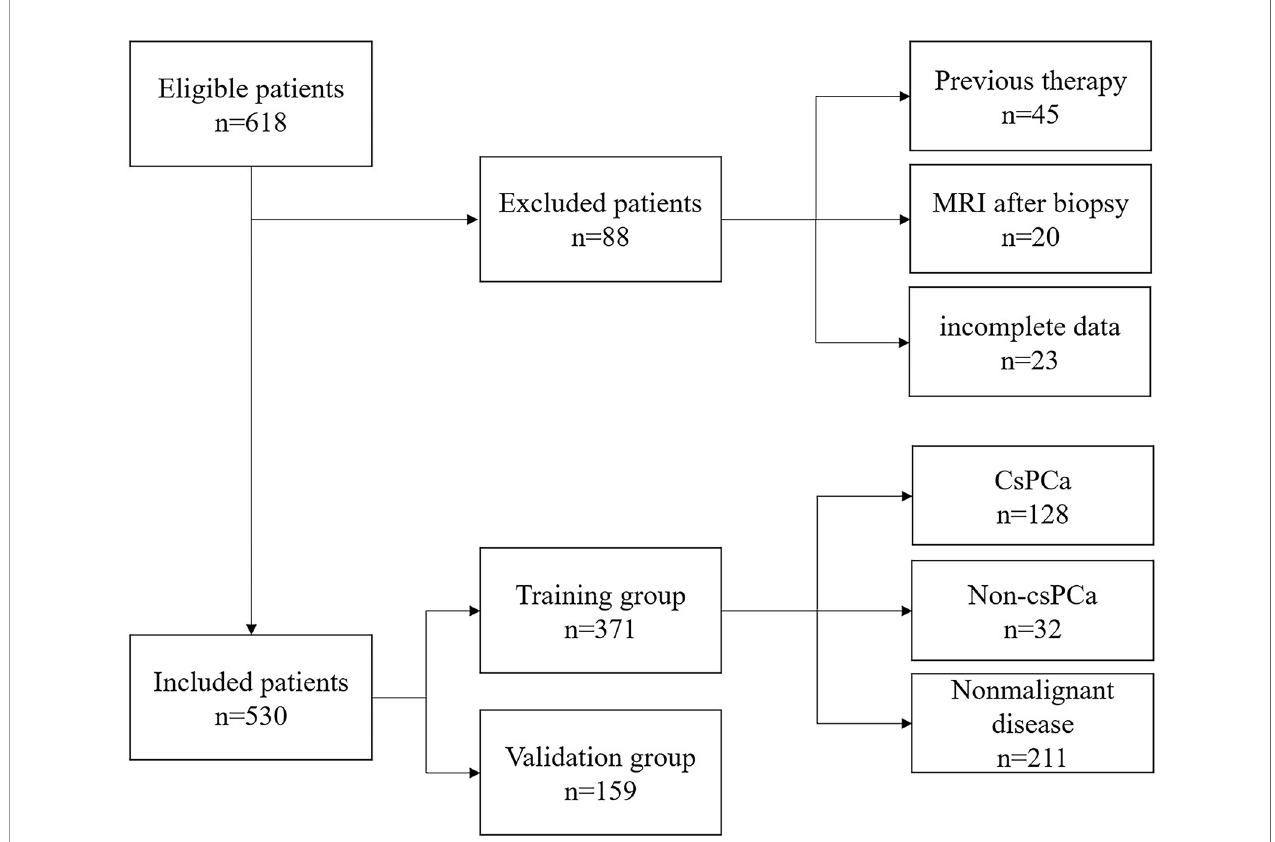
FIGURE 1 | Flow diagram of the inclusion and exclusion criteria in this